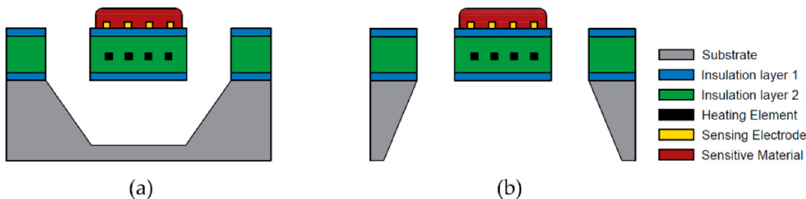
Figure 5. The suspended membrane microhotplate structure formed by ( a ) front-side etching and ( b ) back-side etching.